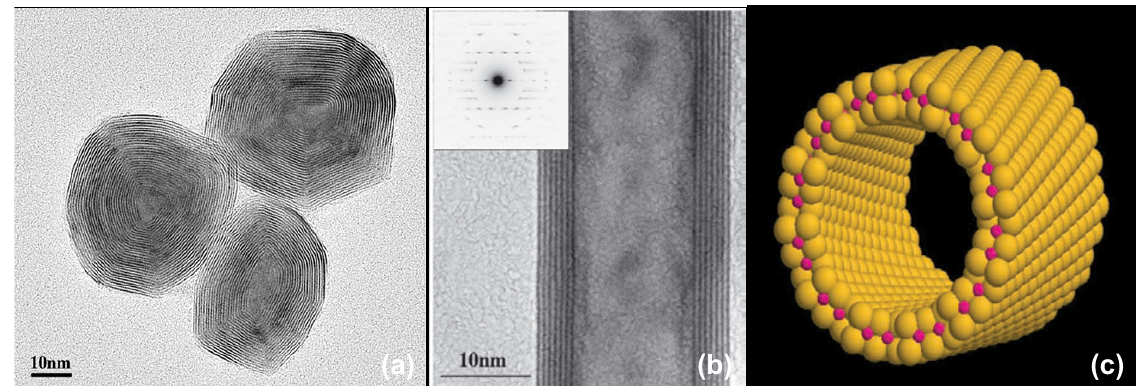
Figure 2. TEM image of (a) IF-WS nanoparticles (b) WS nanotubes produced via the synthetic route with oxide precursors. (c) Model of WS 2 2 nanotube. Unlike the single layer of graphite here each shell consists of a tri-layer structure (adapted from Chem. Mater., 14, 471, 2002 and J. Mater. Chem., 14, 617 (2004)).